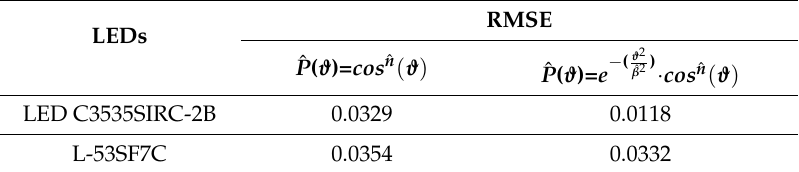
Table 1. RMSE of the two